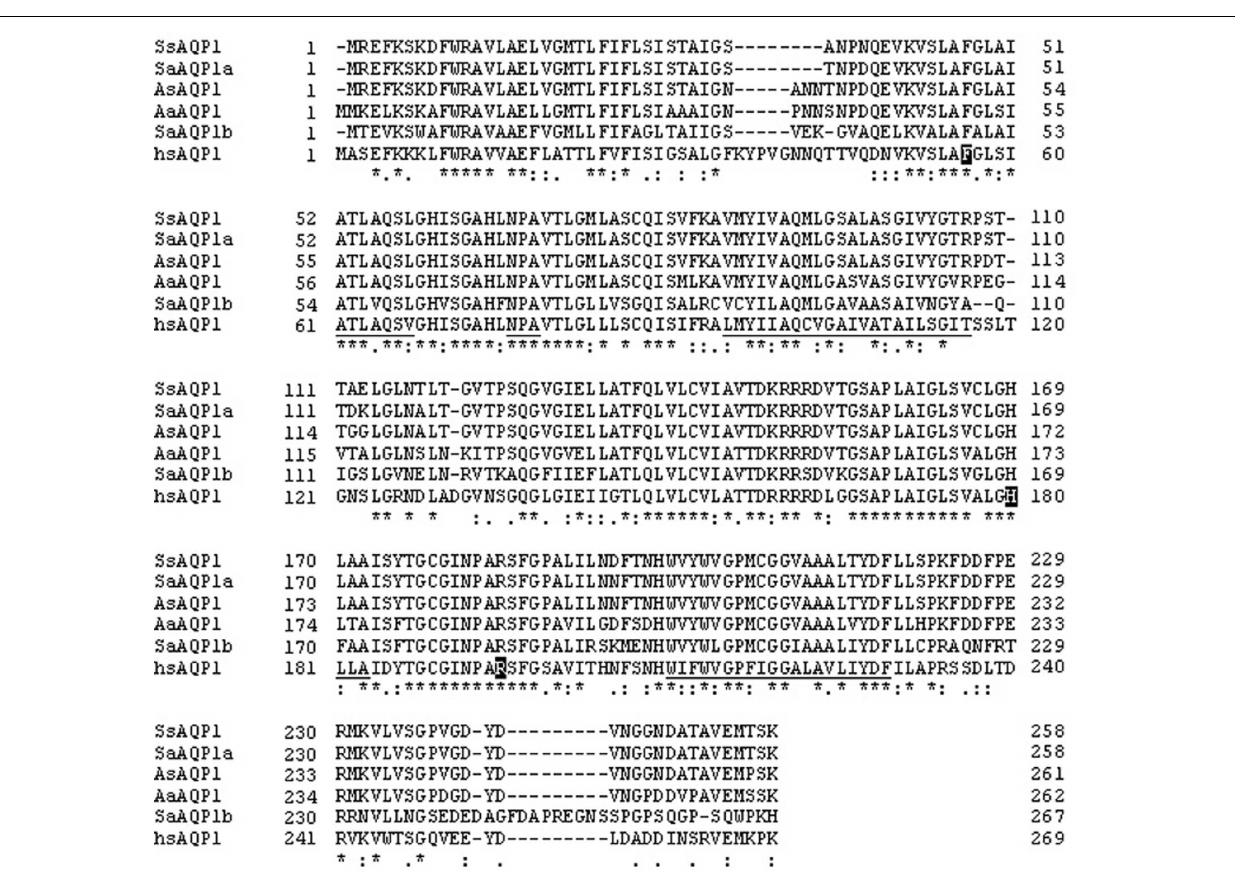
FIGURE 1 | Comparison of amino acid sequences of theAQP1 of silver sea bream (SsAQP1), gilthead sea bream (SaAQP1a), black porgy (AsAQP1), European eel (AaAQP1), human (hsAQP1), andAQP1b of gilthead sea bream (SaAQP1b). Approximate locations of the six transmembrane domains are underlined and two signature NPA motifs are double underlined. Asterisks denote identical amino acid residues among different AQP1 sequences.